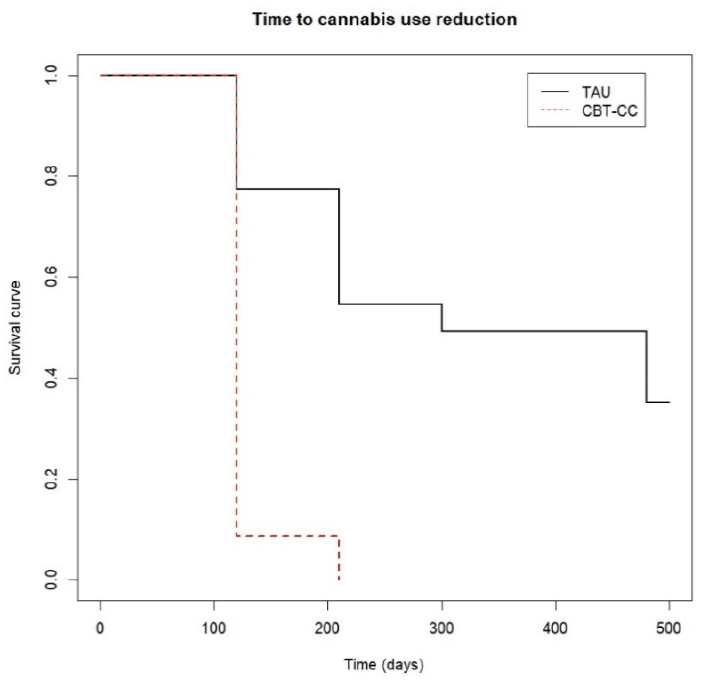
Figure 2. Time to cannabis use reduction.